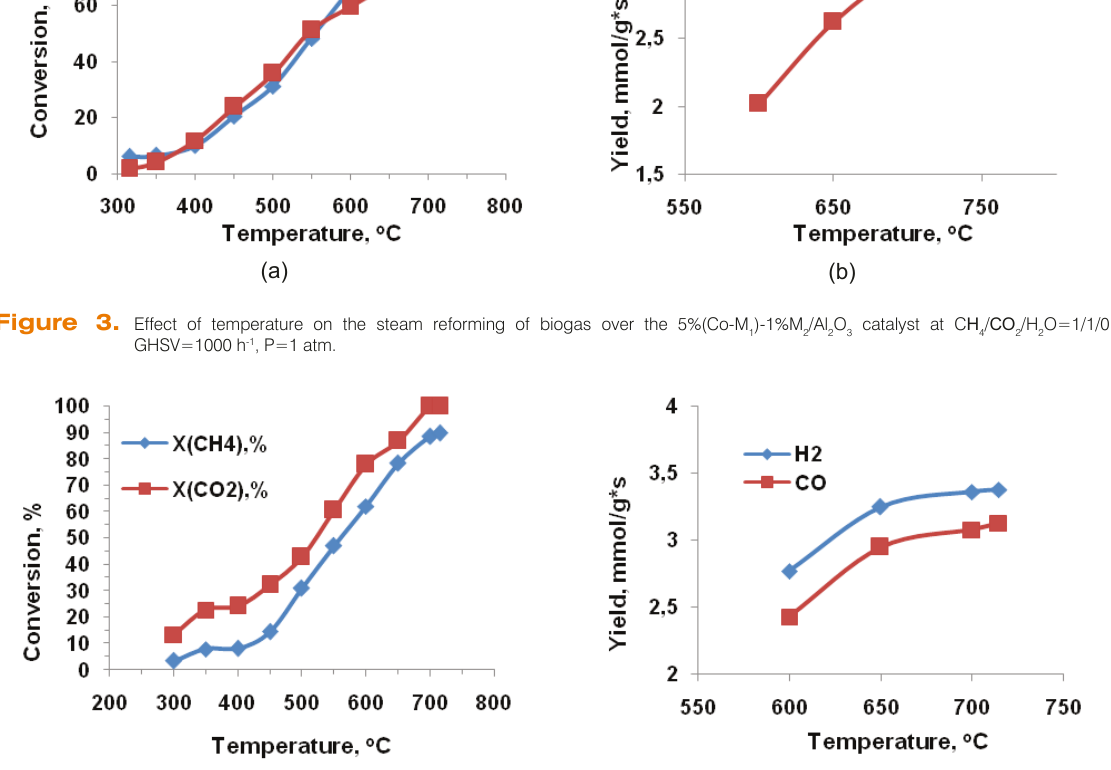
)-1%M /Al O catalyst at C Н 1 2 2 3